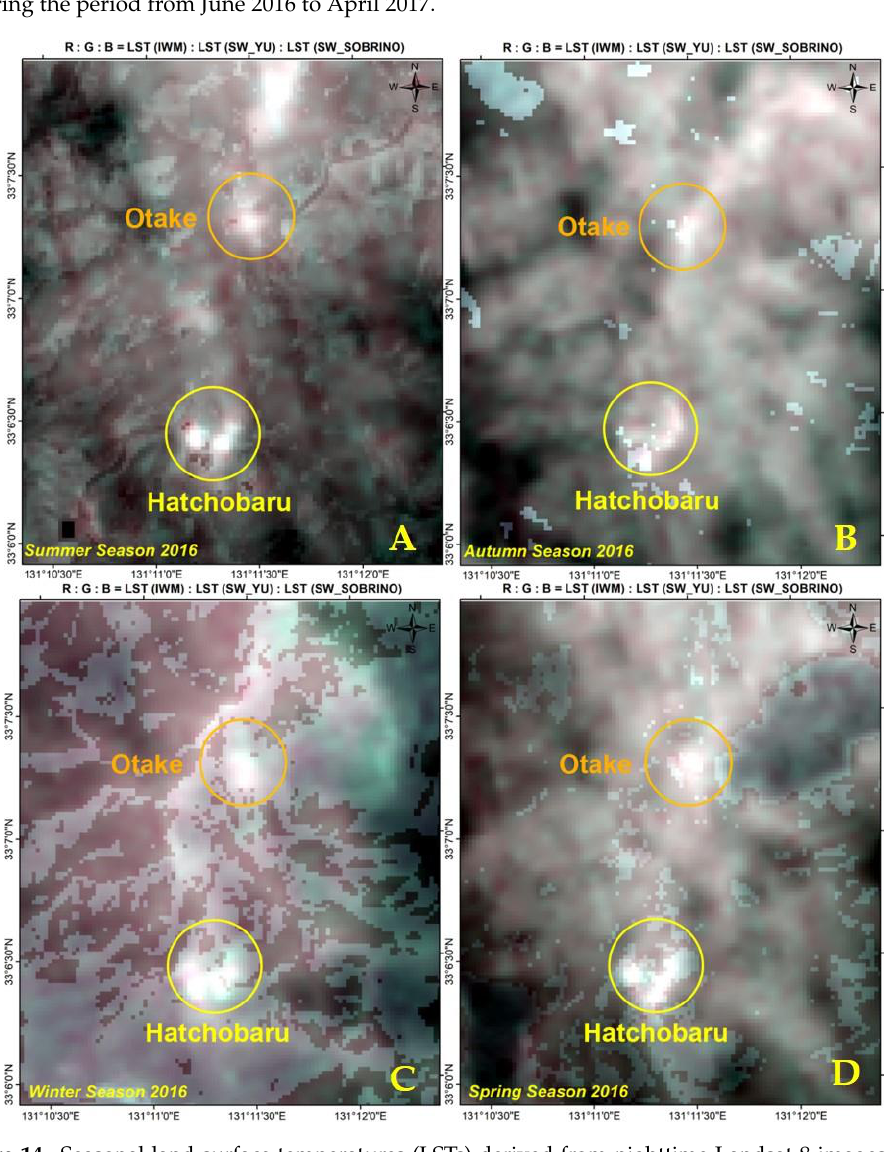
Figure 14. Seasonal land surface temperatures (LSTs) derived from nighttime Landsat 8 images using three different methods are shown as RGB composites. Panels ( A – D ) show the LSTs for summer through spring, based on the improved mono-window and split-window algorithms of Yu et al. [19] and Jiménez-Muñoz et al., respectively, [20] for estimating the LSTs as red, green, and blue colour components of the composite. The white pixels identify the highest anomalies in the LST values, based on all of the methods. The circles are the thermal anomaly areas of Hatchobaru and Otake, used for the RHL estimation separately.